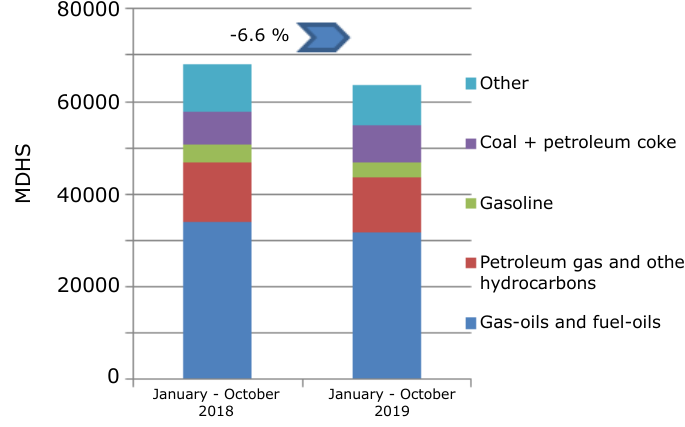
Figure 1. Evolution of the energy dependence imports in Morocco (2018–2019) [16].